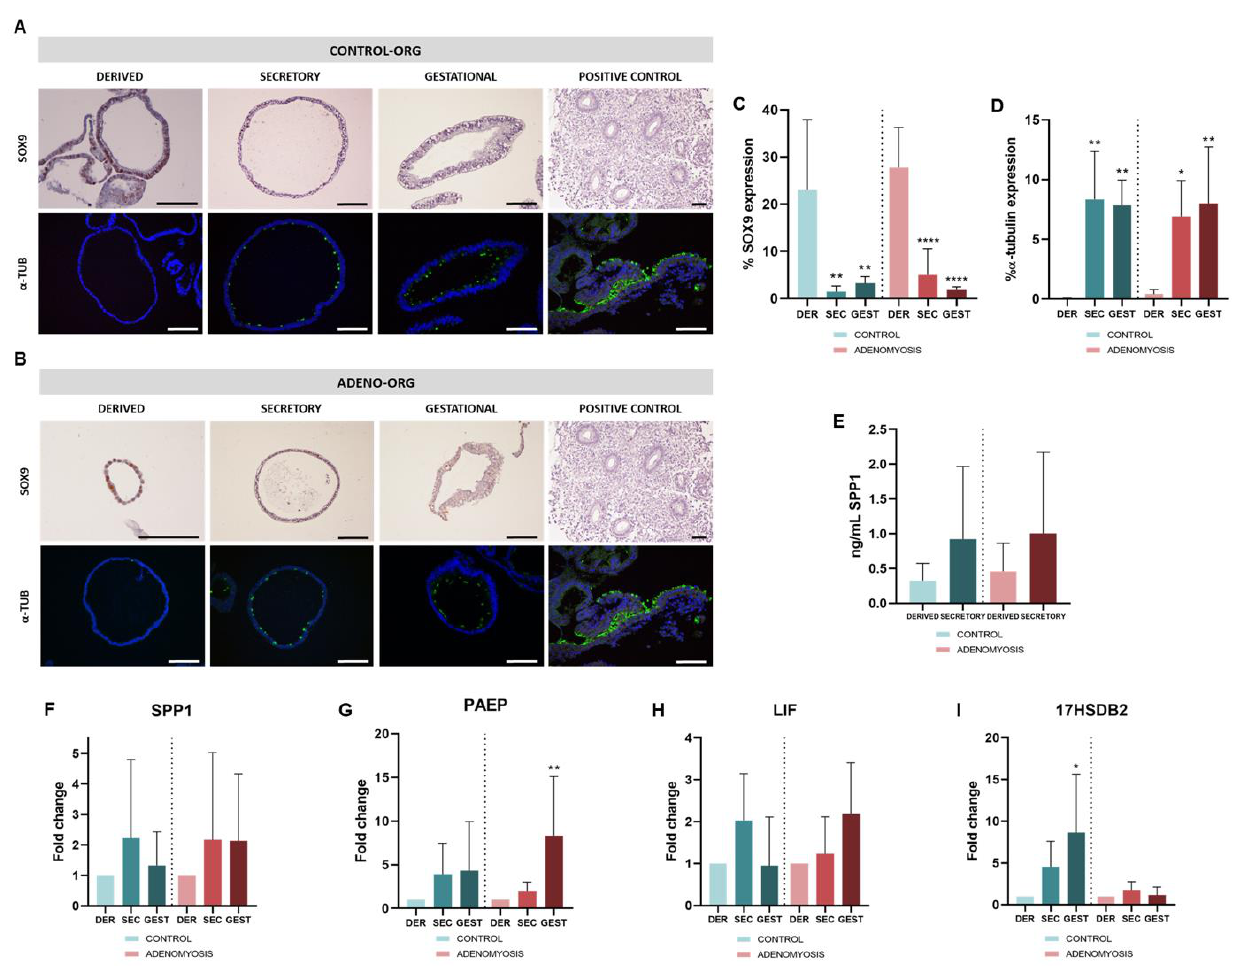
Figure 2. Characterization of sec-organoids and gest-organoids. Representative images of SOX9 and α -tubulin expression in sec-organoids and gest-organoids derived from ( A ) Control and ( B ) Adenomyosis patient samples by IHC and IF. Quantification of ( C ) SOX9 and ( D ) α -tubulin protein expression in derived, secretory, and gestational Control and Adeno organoids. ( E ) SPP1 protein secretion levels in derived, secretory, and gestational Control and Adeno organoids by ELISA. ( F ) SPP1 , ( G ) PAEP , ( H ) LIF , and ( I ) 17 β HSD2 gene expression in derived, secretory, and gestational Control and Adeno organoids by qRT-PCR. Scale bars are 100 µm. Endometrium was used as a positive control. * p < 0.05, ** p < 0.01, **** p < 0.0001.